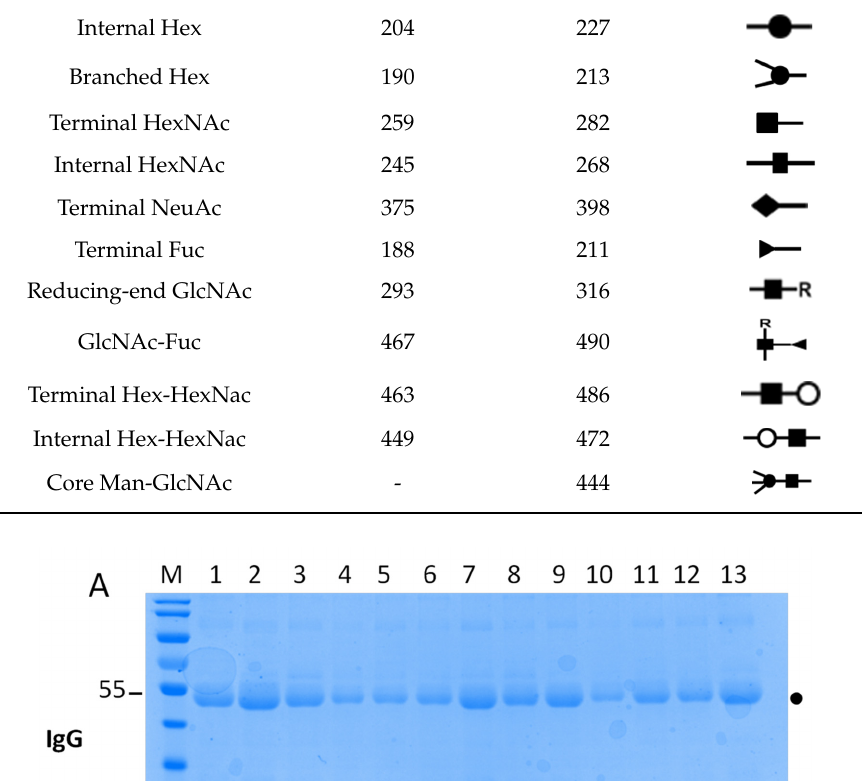
Table 1. Major N-glycans in sera of healthy controls and rheumatoid arthritis patients. m/z